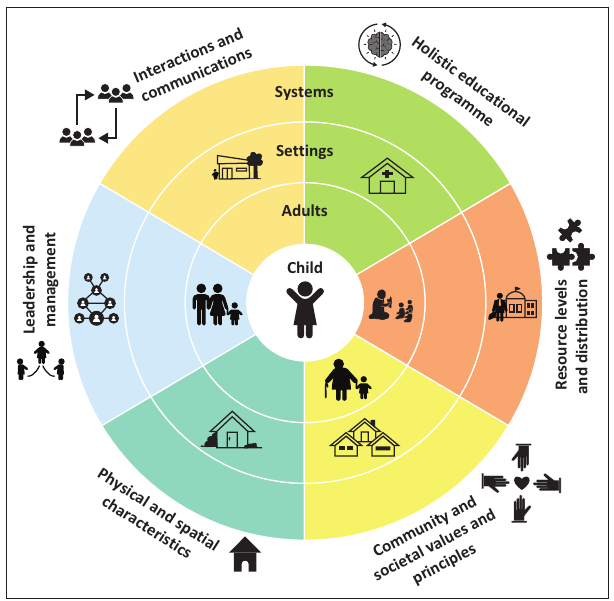
FIGURE 3: Circles of care and